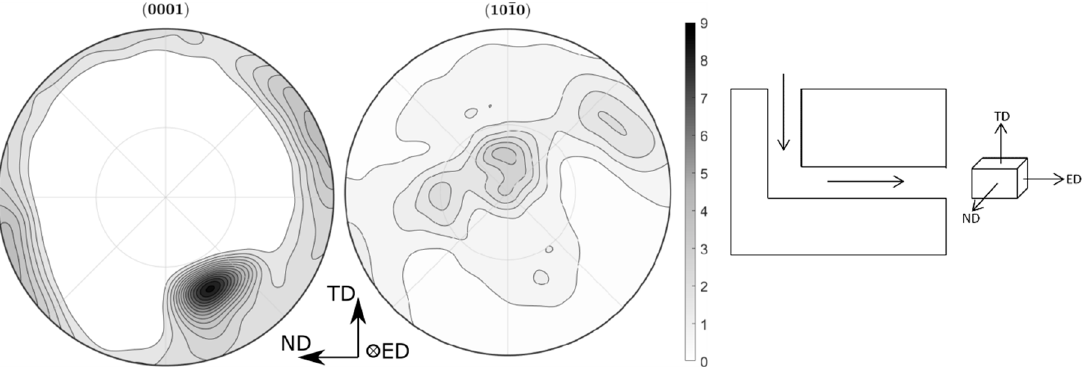
Figure 5. EBSD pole figure of the 8P sample (cross-section).